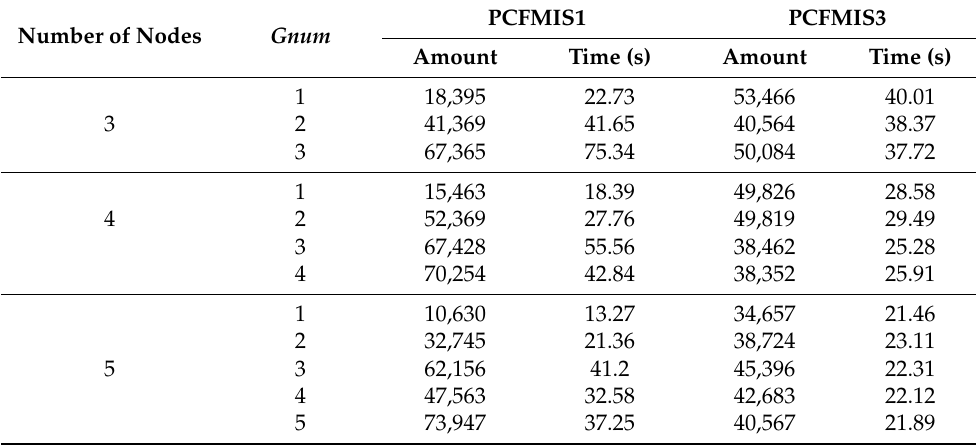
Table 1. The amount of subtrees and computing time in different Gnum groups of CSLOGS10.